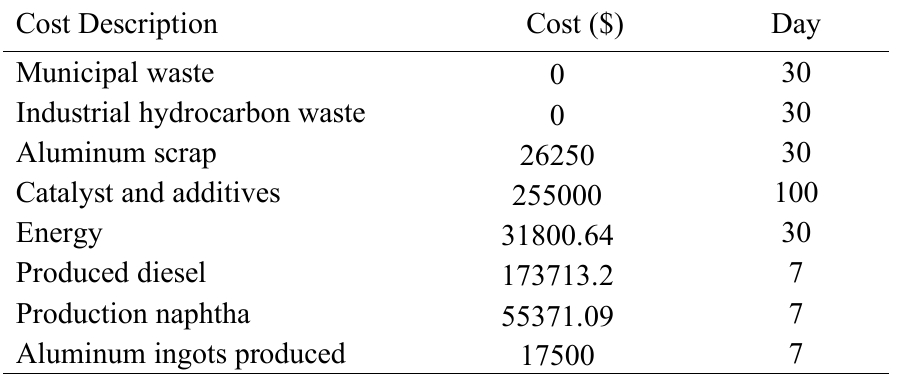
Table 7. Storage inventory